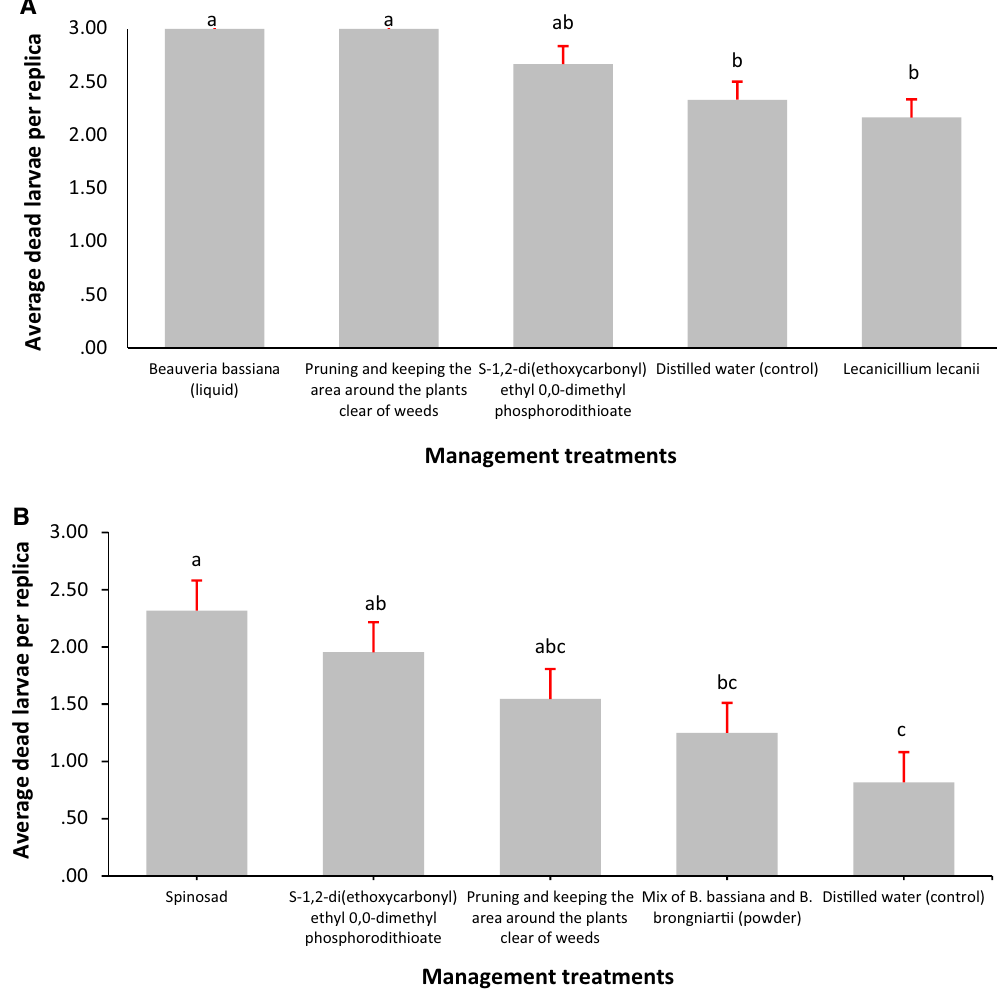
Figure 3. Average number of dead larvae per replicate under field conditions. Different letters indicate statistically significant differences. a C. theobromae . b S. ampliophilobia . Source : Elaborated by the